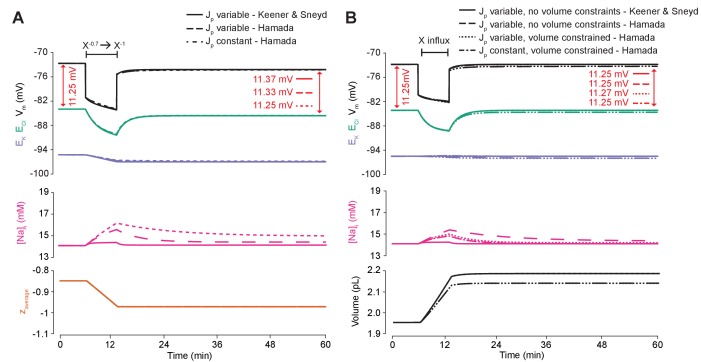
An ATPase model with different kinetics has similar properties to our model’s ATPase when average impermeant anion charge in the cell is changed, and is also dependent on the ATPase pump rate’s dependence on Na+.(A) The experiment for Figure 6A was repeated using the usual ATPase model (solid line) compared to Hamada et al. (2003)’s model and is consistent with the results in the main text. ECl (green), EK (purple) and Vm (black) (top panel), [Na+]i (pink, middle panel) and average impermeant anion charge z (orange, lower panel) over time in the default single compartment model. Changing the average z from −0.85 to −1 generated small, persistent Cl- driving force shifts (arrows) only when the effective ATPase pump rate (Jp) was variable (solid and dashed line) for both pump models, and not when Jp was kept constant (dotted line). (B) The experiment for Figure 6C was repeated comparing the usual ATPase model (solid line) with Hamada et al., 2003’s model and is consistent with the results in the main text. ECl (green), EK (purple) and Vm (black) (top panel), [Na+]i (pink, middle panel) and cell volume (black, lower panel) over time in the default single-compartment model. Impermeant anions of the same average charge of the cell were added. A volume constraint on Hamada et al.’s model was incorporated by adding a hydrostatic force dependent on membrane tension (dotted lines), which resulted in an impermeable anion induced transmembrane osmotic differential. This caused a small change in Cl- driving force when Jp was variable (dotted line), but not when Jp was held constant (dash-dotted lines).